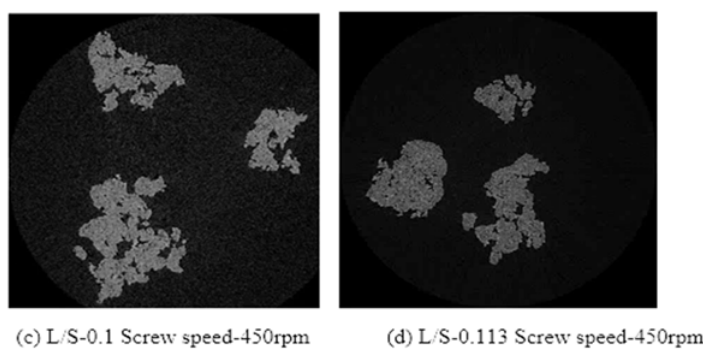
Figure 8. X ‐ ray tomographic images of granules produced using SuperTab11SD at varying L/S (screw speed, 450 rpm).